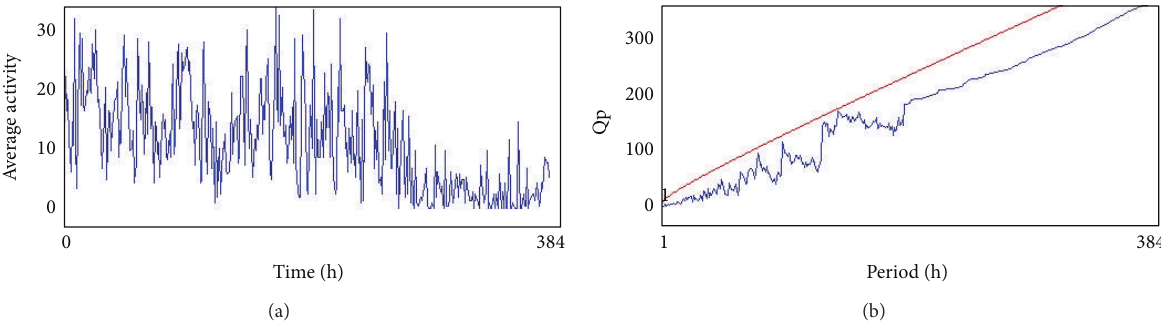
Figure 10: (a) and (b) show the average activity pattern and chi-square periodogram, respectively, for the PD flies exposed to 1.0 𝜇 L/mL of Centella asiatica leaf extract in diet ( 𝑁 = 20 ).